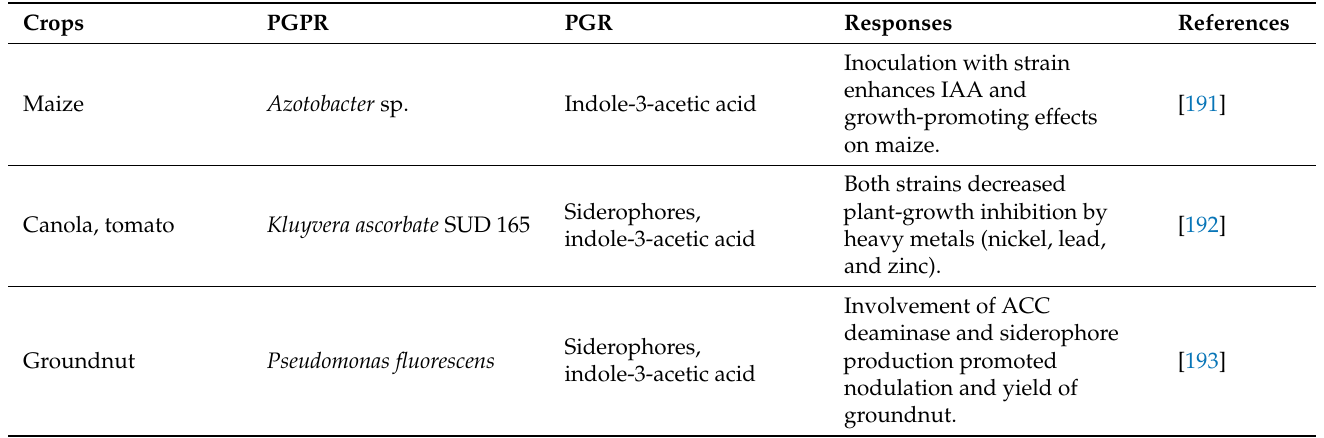
Table 3. Production of various plant-growth regulators (PGRs) in response to PGPR inoculation in different